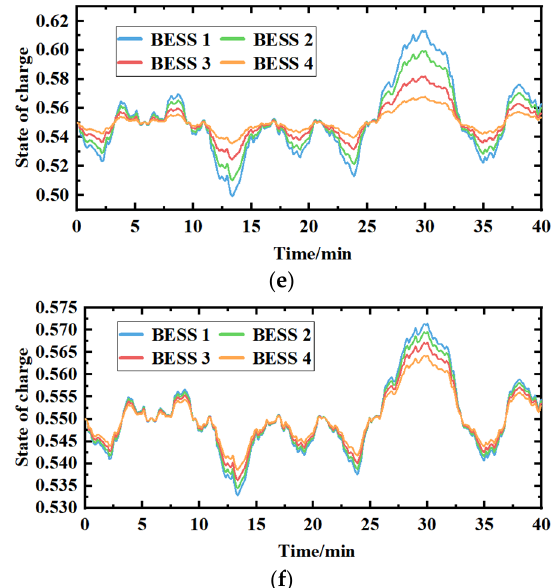
Figure 8. ( a ) Continuous load perturbation; ( b ) frequency deviation comparison graph; ( c ) the output of BESSs for Scheme 2; ( d ) the output of BESSs for Scheme 3; ( e ) battery charge state diagram for Scheme 2; ( f ) battery charge state diagram for Scheme 3.